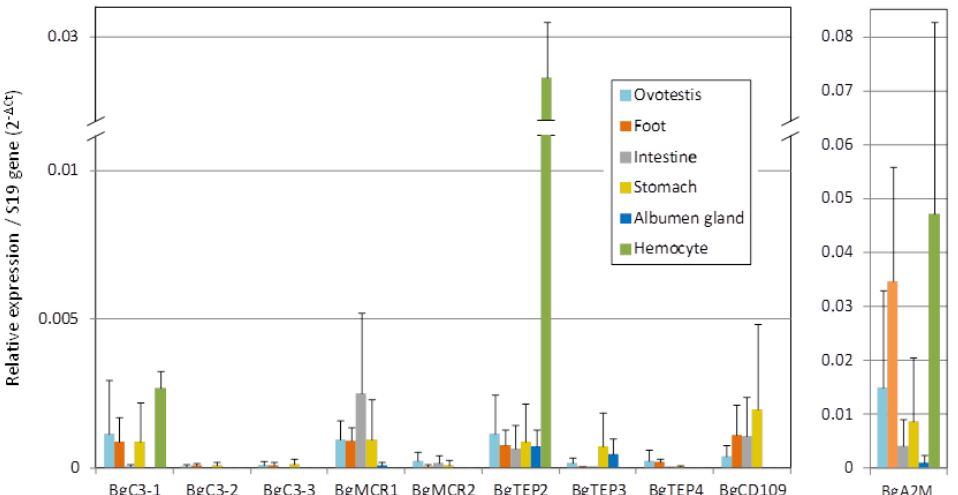
Figure 4. Relative expression of BgTEP genes in snail tissues. Transcription profile of BgTEPs in di ff erent tissues derived from nine individual snails. Six snail tissues were dissected: Ovotestis, head-foot, intestine, stomach, albumen gland. Six pools of hemocytes were each collected from 20 snails. Quantitative RT-PCR was performed on mRNA. C t values of transcripts were normalized to the transcript level of the reference S19 ribosomal protein gene. Error bars represent the SD of the ∆ C t mean values obtained for each tissue. BgA2M is presented apart as transcripts level reaches a di ff erent scale.